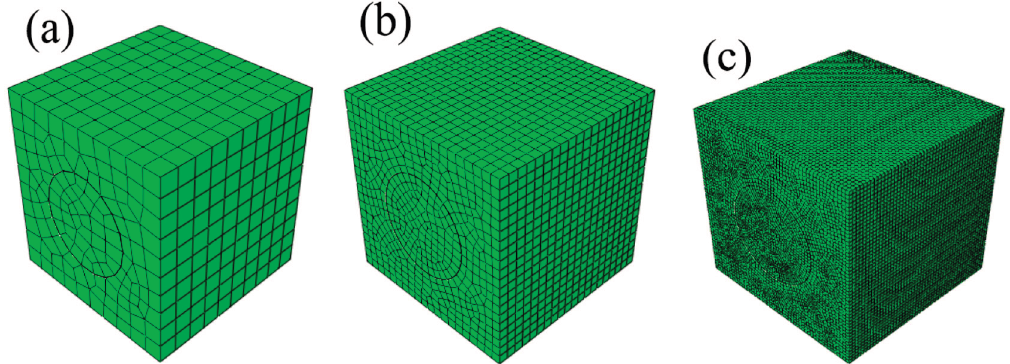
Figure 3. Mesh-sensitivity analysis in the nonlinear analyses: ( a ) coarse; ( b ) medium; and ( c ) fine mesh densities.